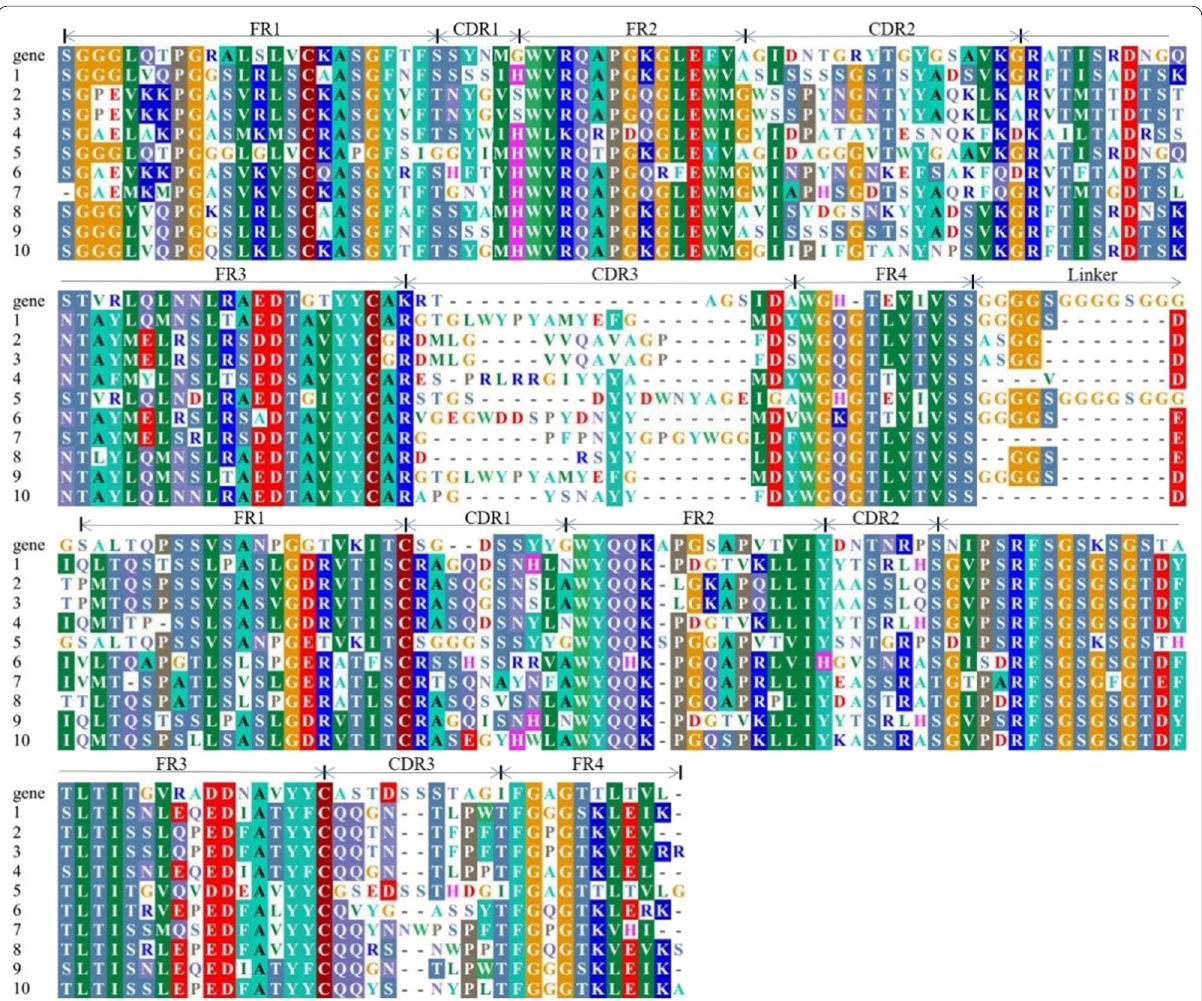
Fig. 6 Sequence analysis of V L and V H genes of IgY-scFv. scFv antibody from randomly selected clones from the fourth bio-panning. The amino acid sequences of V H and V L in ten scFv clones to be aligned with those of the chicken germline sequence (gene) (Kovacs-Nolan and Mine 2004). FR: Framework region; CDR: complementarity determining